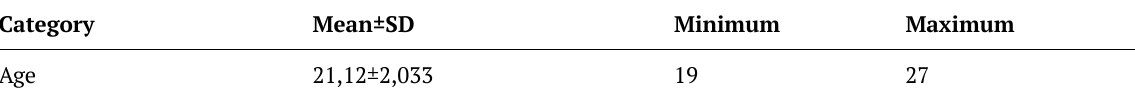
Table 2. Demographic results of the sporting codes and training frequencies